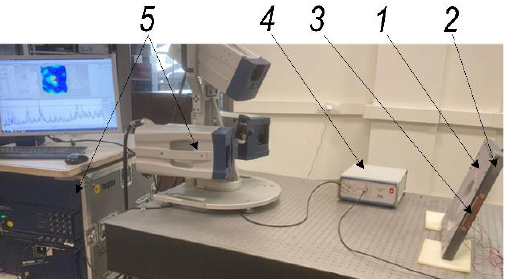
Figure 1. 3D scanning experimental set-up for the investigation of vibration modes of the metal sheet rigidly attached to the frame: 1—an experimental body—aluminum alloy sheet; 2—steel base